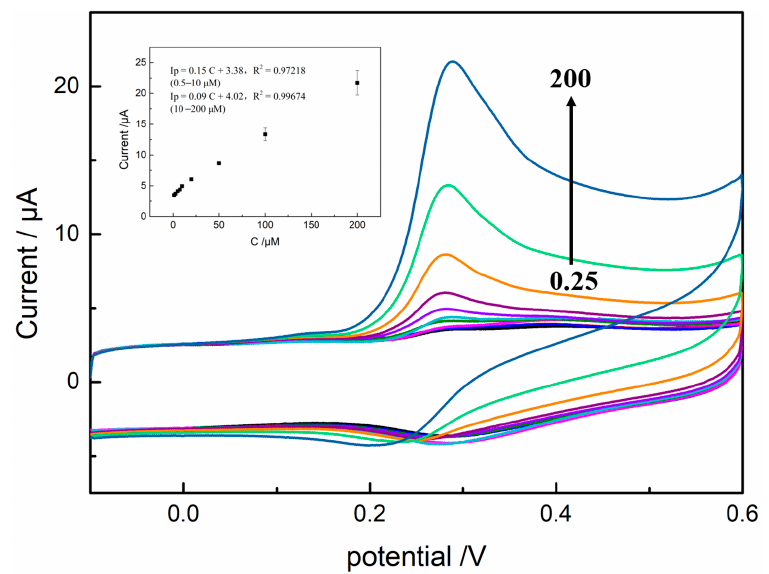
Figure 8. CV curves of various concentrations of GA on Co-MOF/CNTs/SiO 2 /AuE (Inset: the linear relationship of Ip and GA concentrations). Table 3. Compared with other recent reported electrochemical detection of GA.